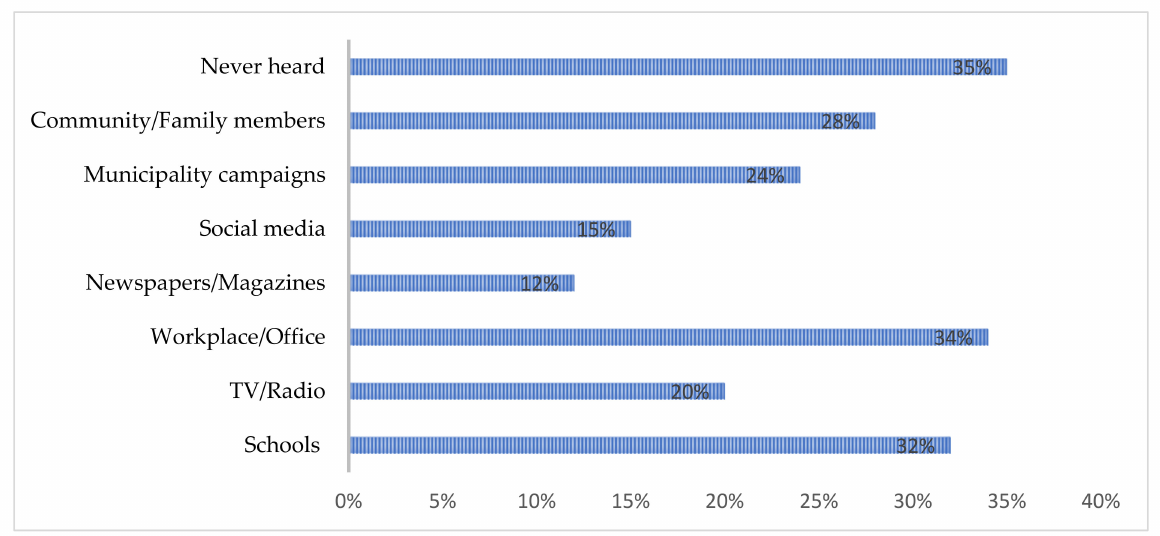
Figure 3. E-waste information sources from the household